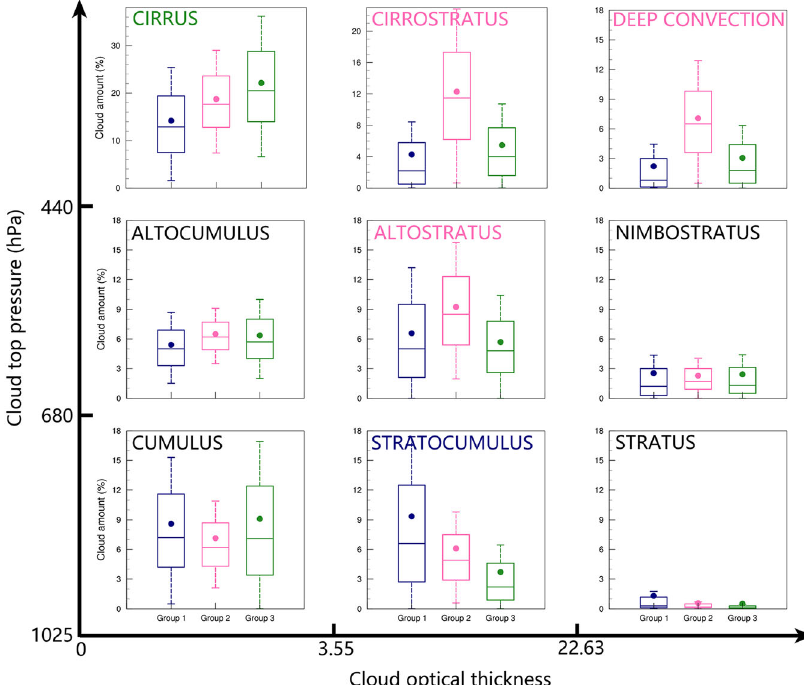
Fig. 4 Box plots of cloud amount with different cloud types for Group-1, 2, and 3. The cloud types are classi fi ed by the values of cloud top pressure and cloud optical thickness. The cloud-type text with blue, pink, and green colors indicate the principal cloud type(s) of Group-1, Group-2, and Group-3, respectively. Group-1, 2, and 3 are the thunderstorms with mostly liquid clouds, the thunderstorms with strong lightning density, and the thunderstorms with mostly ice clouds, respectively. The black-colored cloud-type texts refer that the three groups of cloud amount are equal in magnitude or all the three groups of cloud amount have a small proportion. The dots represent the mean values, the horizontal lines inside the boxes are the medians, and the bottom and top sides of the boxes represent the fi rst and third quartiles. The whiskers are the minimum (maximum) values within 1.5 interquartile ranges of the lower (upper) quartile.